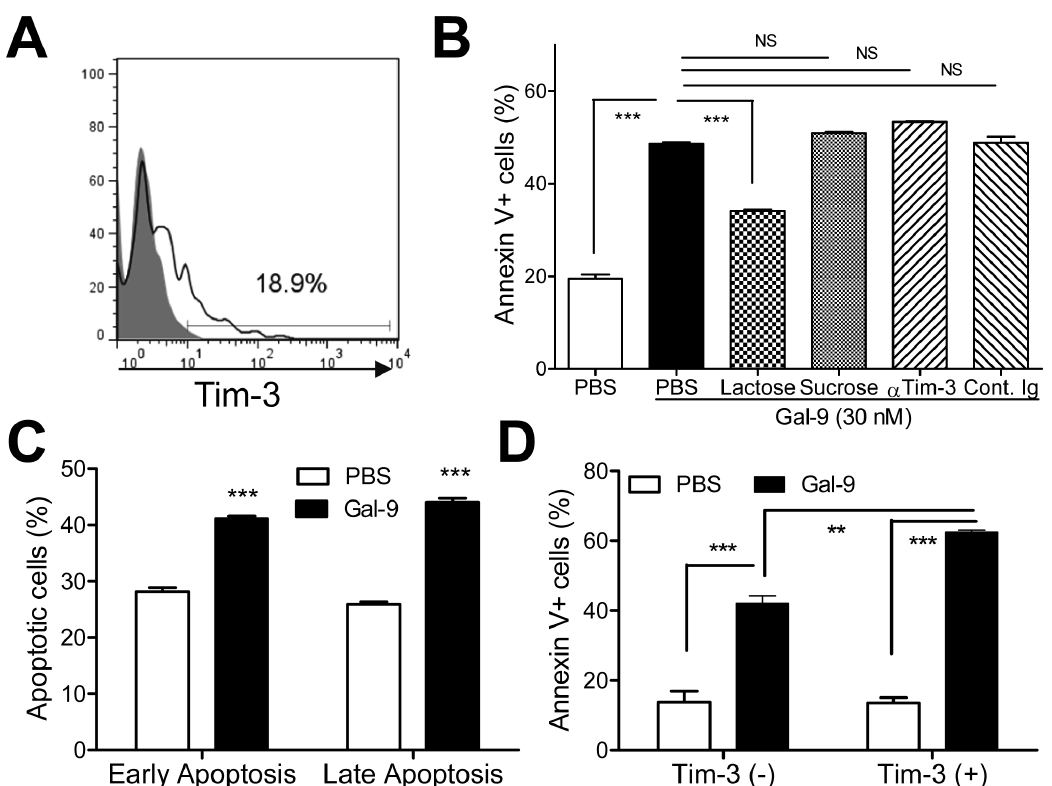
Figure 7. Gal-9 Induces plasma cell apoptosis independently of Tim-3. ( A ) Plasma cells express Tim-3. Tim-3 expression on CD19 2 /low CD138 + cells of spleen cells from 12-week-old MRL/lpr lupus-prone mice was assessed. The results shown are representative data from one of four independent experiments. Filled histogram represents isotype-matched control. ( B ) Induction of plasma cell apoptosis by Gal-9. Plasma cells were treated with 30 nM Gal-9 for 5 h in the presence or absence of lactose, in quadruplicate. (***, P , 0.001; NS, not significant). ( C ) Gal-9 induces both early (Annexin V + 7AAD 2 ) and late (Annexin V + 7AAD + ) apoptosis of plasma cells from MRL/lpr mice. Plasma cells were treated with 30 nM Gal-9 for 5 h in quadruplicate. (***, P , 0.001). ( D ) Susceptibility of Tim-3 + plasma cells to Gal-9. Plasma cells were treated with Gal-9 for 5 h. The frequency of Annexin V + cells was assessed in quadruplicate. (***, P , 0.001; **, P , 0.01; NS, not significant).